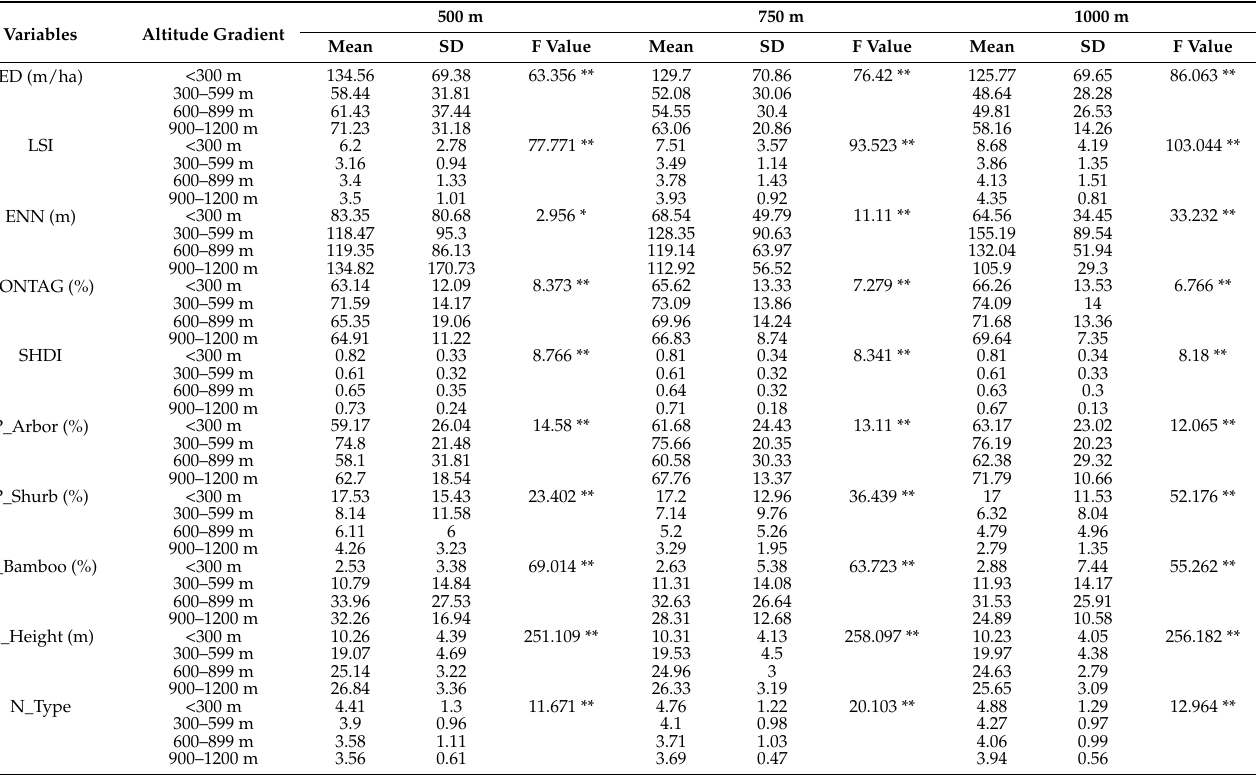
Table 1. Average values ( ± standard error) for variables of each altitude gradient (** is p < 0.01; * is p <